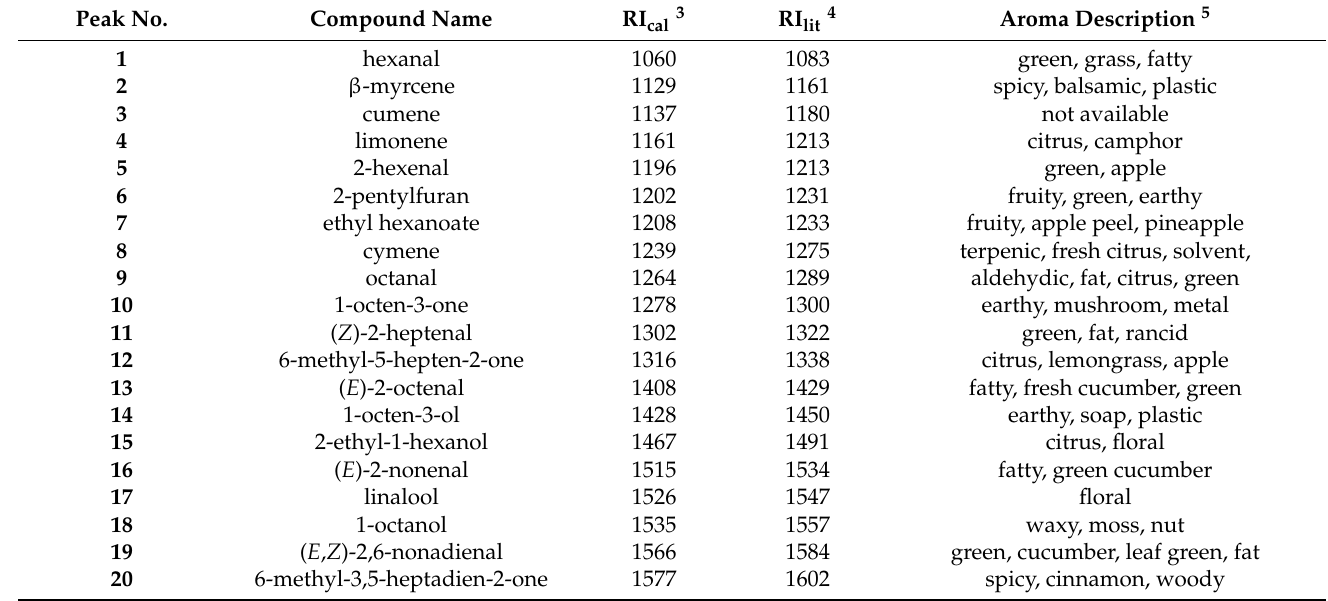
Table 4. Volatile compounds tentatively identified by comparison of calculated and literature retention indices (RI cal 1 and RI lit , respectively) for M3 2 reconstituted in water (63 g powder/L), before storage and after storage at 40 ◦ C/65% relative humidity for 1 month in glass sealed vials and semi-permeable sachets. Peak